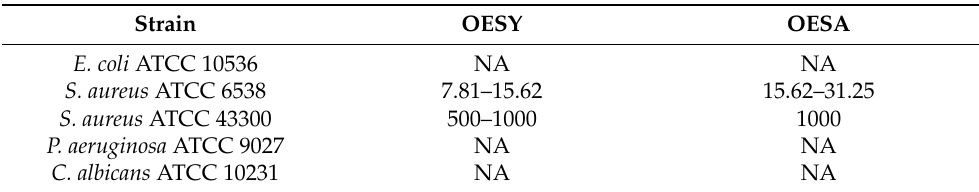
Table 2. MICs of OESY and OESA (expressed as µ g/mL) against Gram-positive bacteria, Gram- negative bacteria, and the yeast C. albicans .